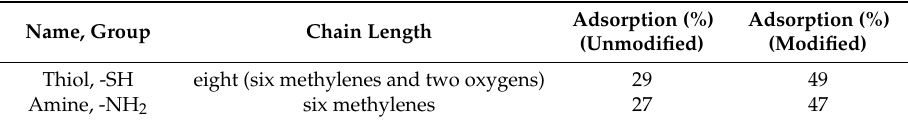
Table 1. Comparison of Cu (II) removal by modified tea leaves.